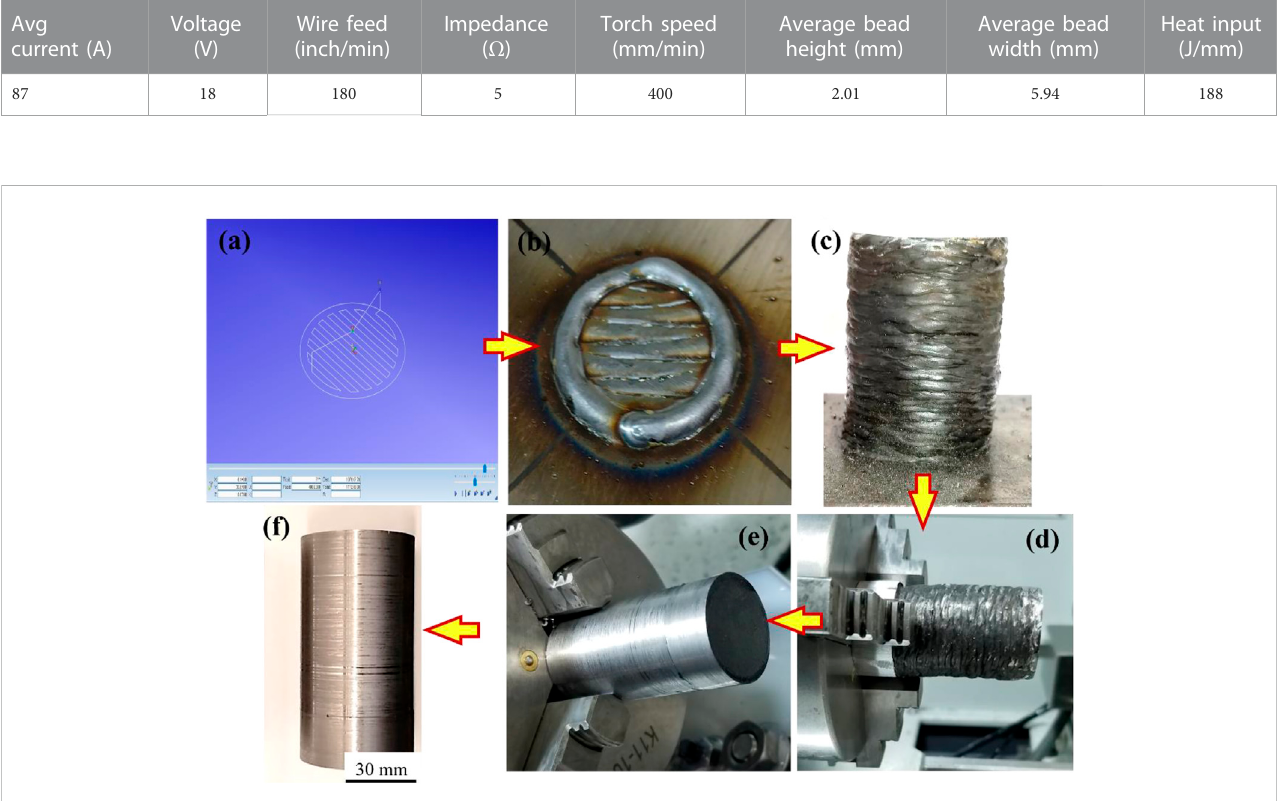
FIGURE 3 H-WAAM processing of solid cylinder — (A) Schematic of the toolpath strategy used for printing; (B) fi rst layer deposition displaying desirable bead overlap, (C) printed solid cylinder, (D) printed cylinder mounted for a turning operation, (E) and (F) machined solid cylinder.